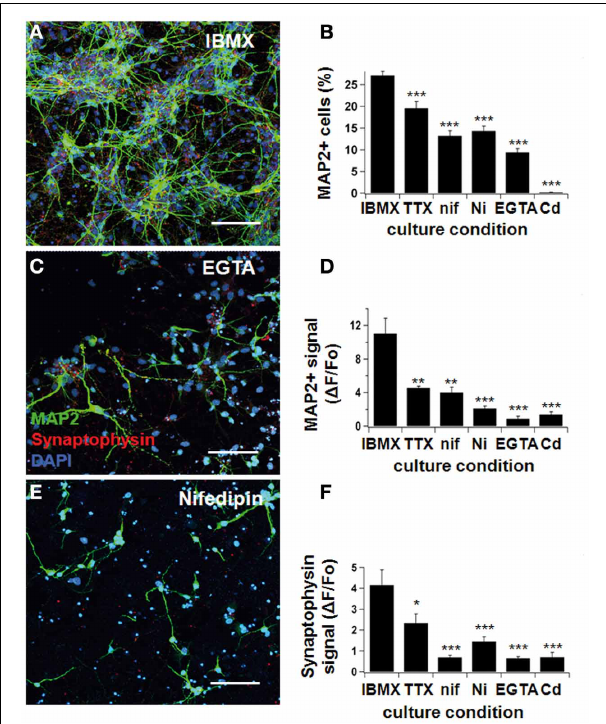
FIGURE 4 | Neurodifferentiation was impaired by Ca 2 + -blockers. NPCs were cultivated in IBMX, as previously described. One hundred nanomolar tetrodotoxin, 10 μ M nifedipine, 50 μ M Ni 2 + , 500 μ M EGTA, and 50 μ M Cd 2 + were added to the culture medium. After 7 days, cultures were fixed and stained for MAP2ab and synaptophysin, and pictures were taken under a confocal microscope (A,C,E) . Neuronal differentiation was ascertained three different ways: by counting the number of MAP2-positive cells (B) , by determining the fluorescence signal intensity for MAP2 (D) , and synaptophysin (F) by confocal microscopy (see text). The yield of neuronal cells was significantly reduced when Na + - and Ca 2 + -blockers were added to the culture medium. Green represents AlexaFluor 488 and red, AlexaFluor 568. Scale bars 150 μ m.